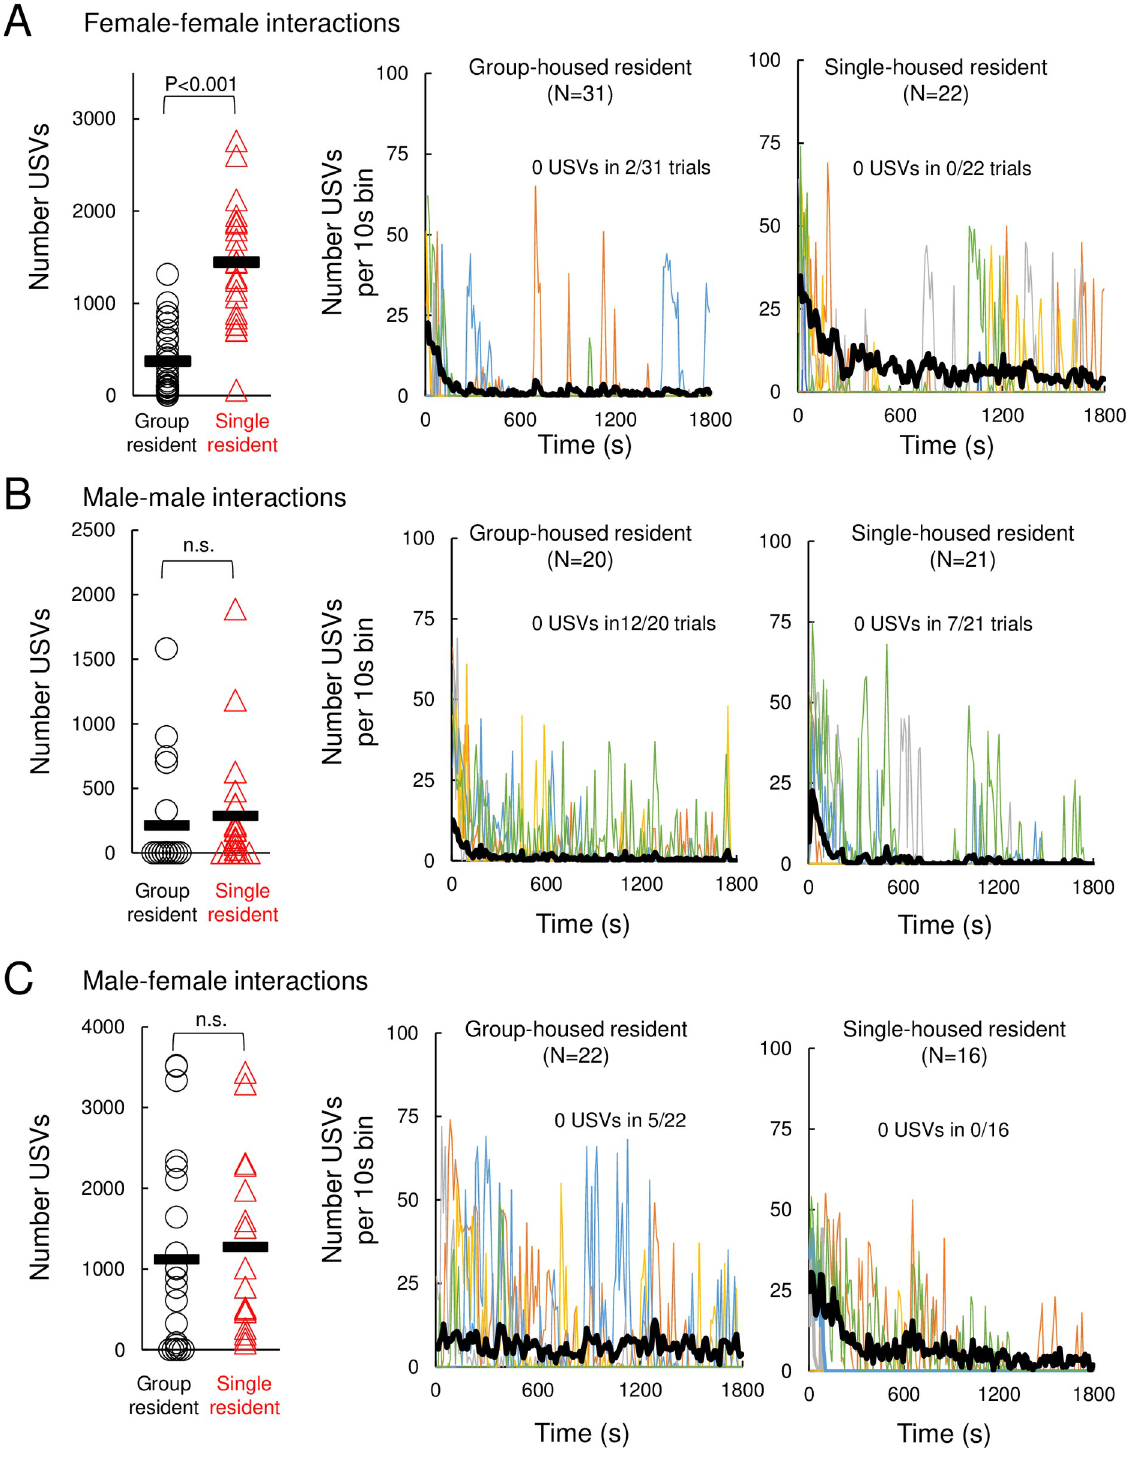
Fig 1. Effects of acute isolation on USV production during same-sex and opposite-sex social encounters. (A) Number of USVs recorded is shown for female-female social encounters, in which a group-housed female visitor was introduced into the home cage of either a group- housed or a single-housed resident. Left panel shows total number of USVs produced during social encounters with group-housed and single- housed female residents. Middle panel (trials with group-housed residents) and right panel (trials with single-housed residents) show the dynamics of USV production over time, plotted as total number of USVs produced in each 10s-long bin. Black line shows mean values for